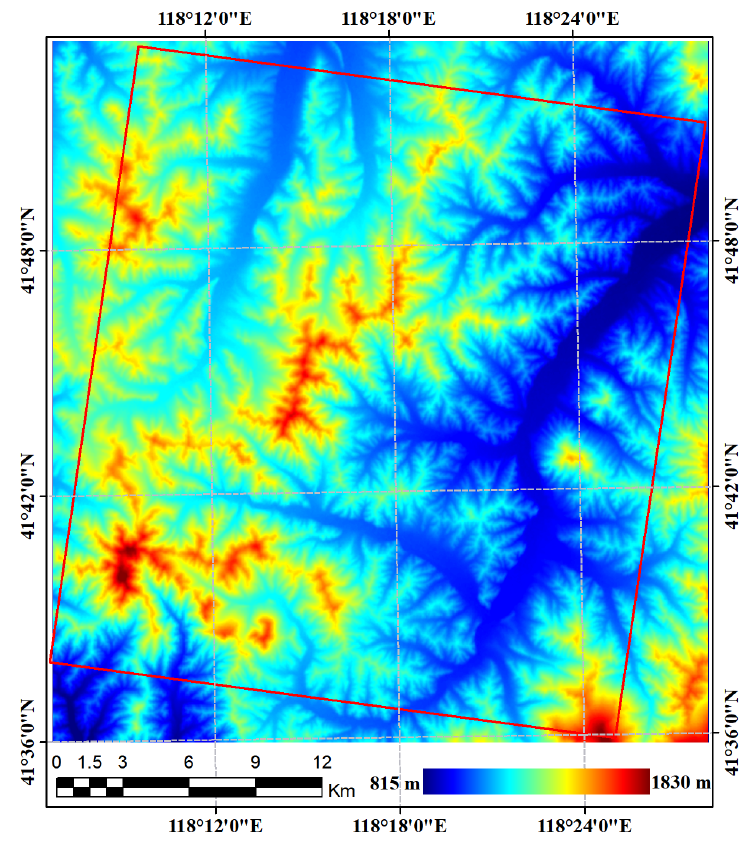
Figure 3. The SRTM DEM of the test site.